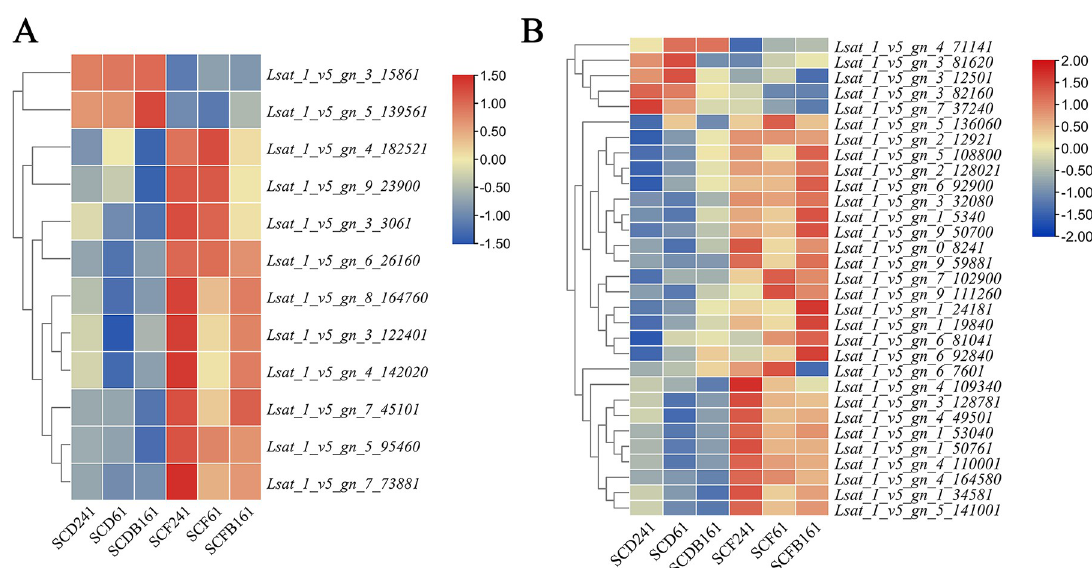
Fig 2. Expression profiles of DGEs under CO 2 enrichment. A and B respectively indicated structural genes and transcription factors responding to CO 2 enrichment.